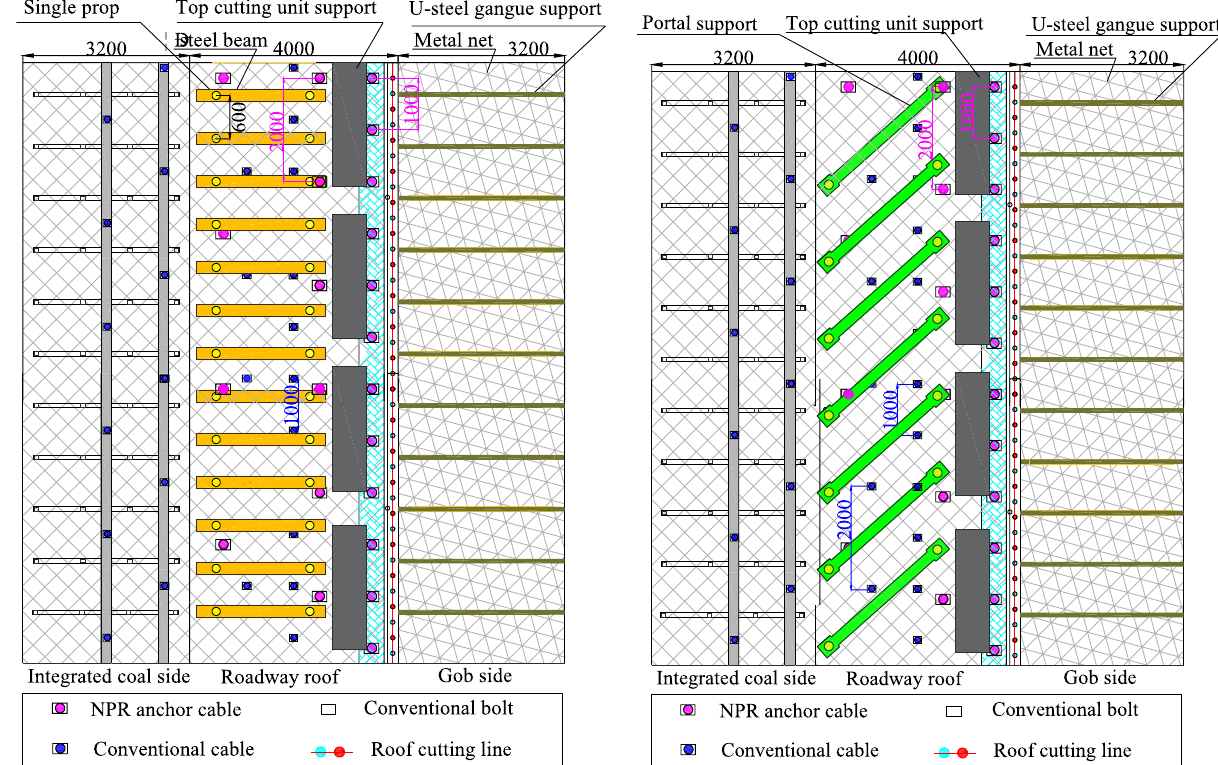
Figure 19. Support design for the formed roadway under the influence of a fault and above a coal